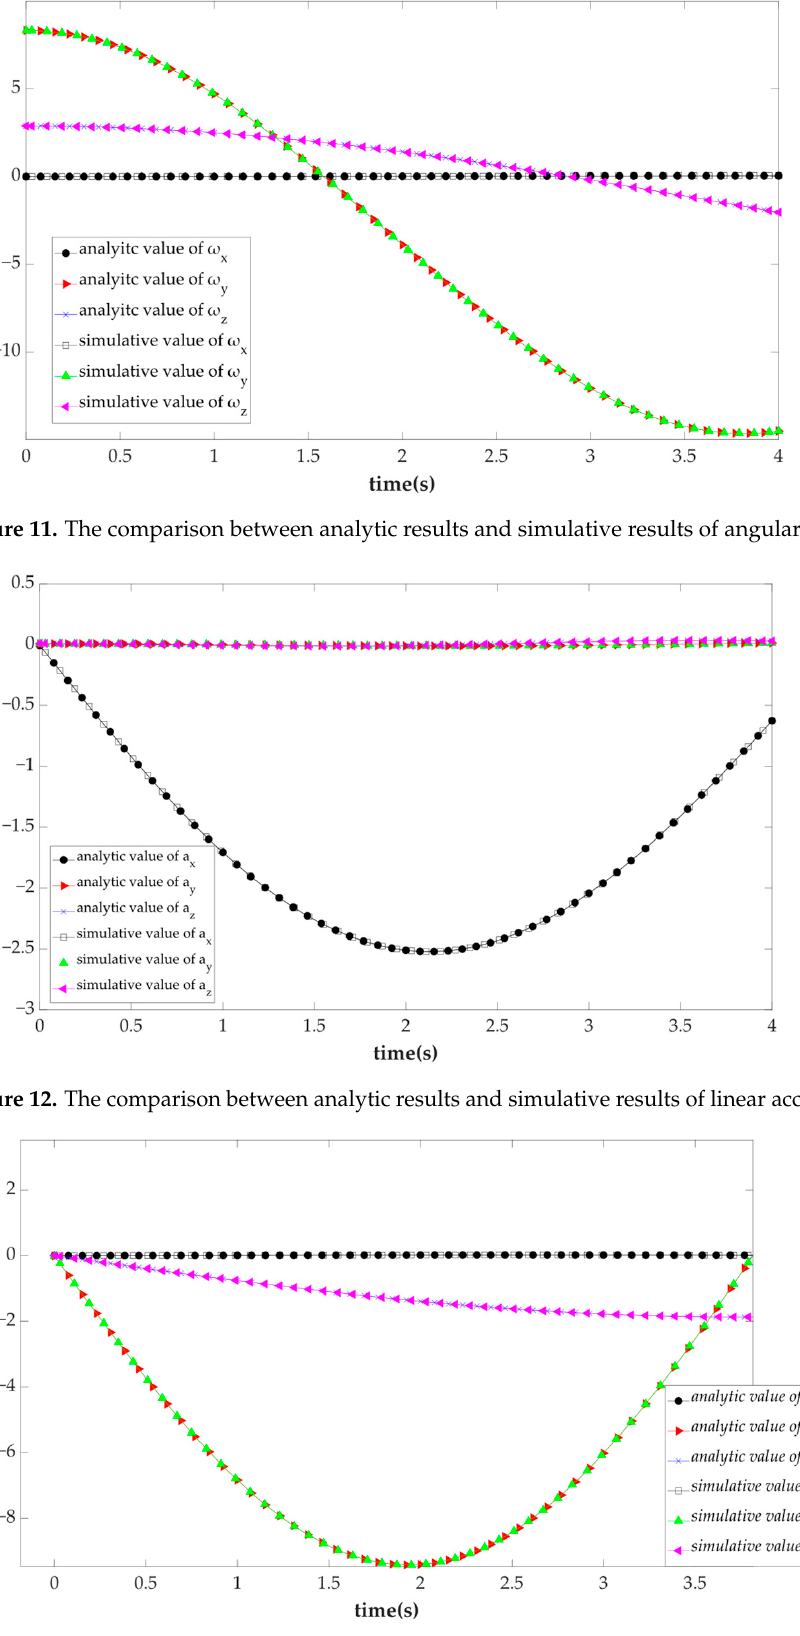
Figure 13. The comparison between analytic results and simulative results of angular acceleration of m .